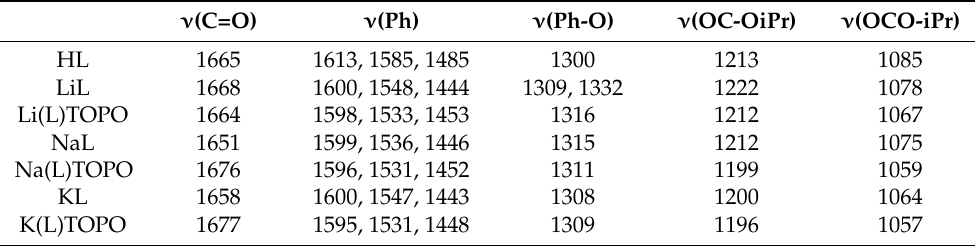
Figure 8. IR-spectra a—HL (L), b—Li(L)TOPO, c—Na(L)TOPO, d—K(L)TOPO. Table 4. Some bands in the IR spectra for HL and complexes of alkali metals (cm − 1 ).